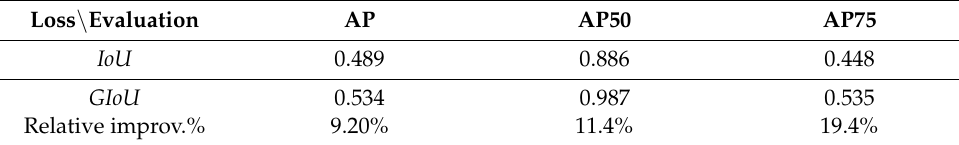
Table 5. Comparison of model performance between IoU and GIoU losses. Loss \